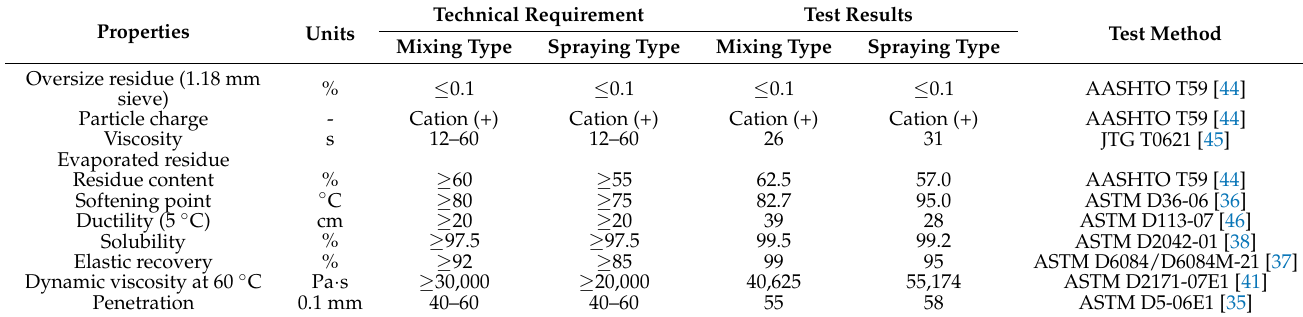
Table 2. Technical index of high-viscosity emulsified bitumen.